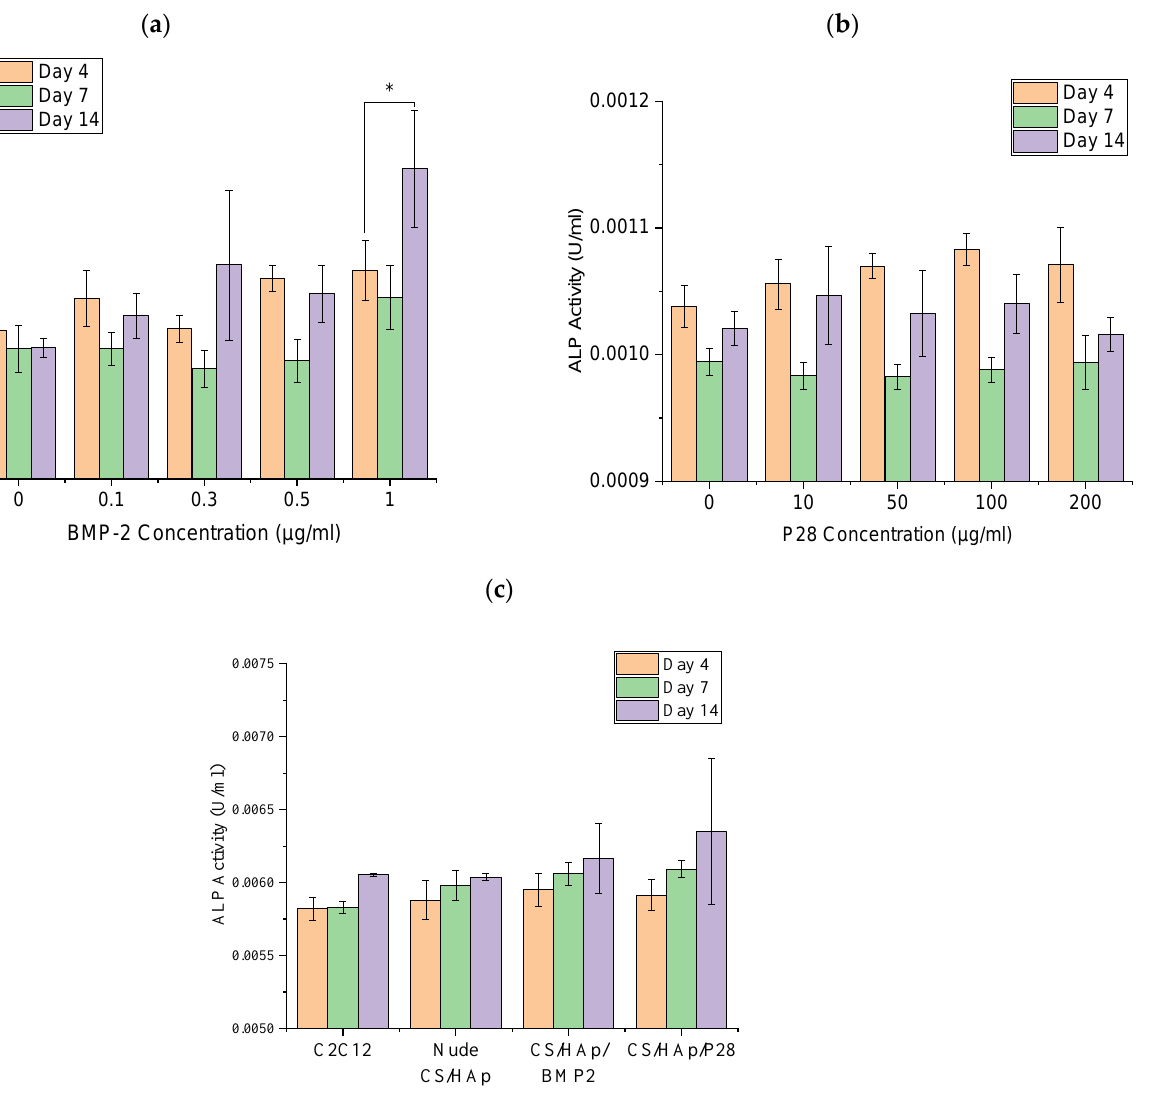
Figure 3. Alkaline phosphatase response of C2C12-treated with various concentrations of ( a ) BMP-2 and ( b ) P28 controls and ( c ) the CS/HAp scaffolds. An increased ALP response was observed in the culture with 1 µg/mL BMP-2 after 14 days, despite the high background control.